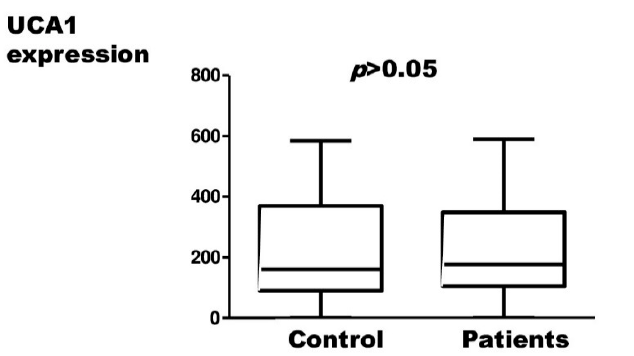
Figure 2. Relative expression of the UCA1 in endometriosis patients with respect to the control material (Mann–Whitney test; p > 0.05).